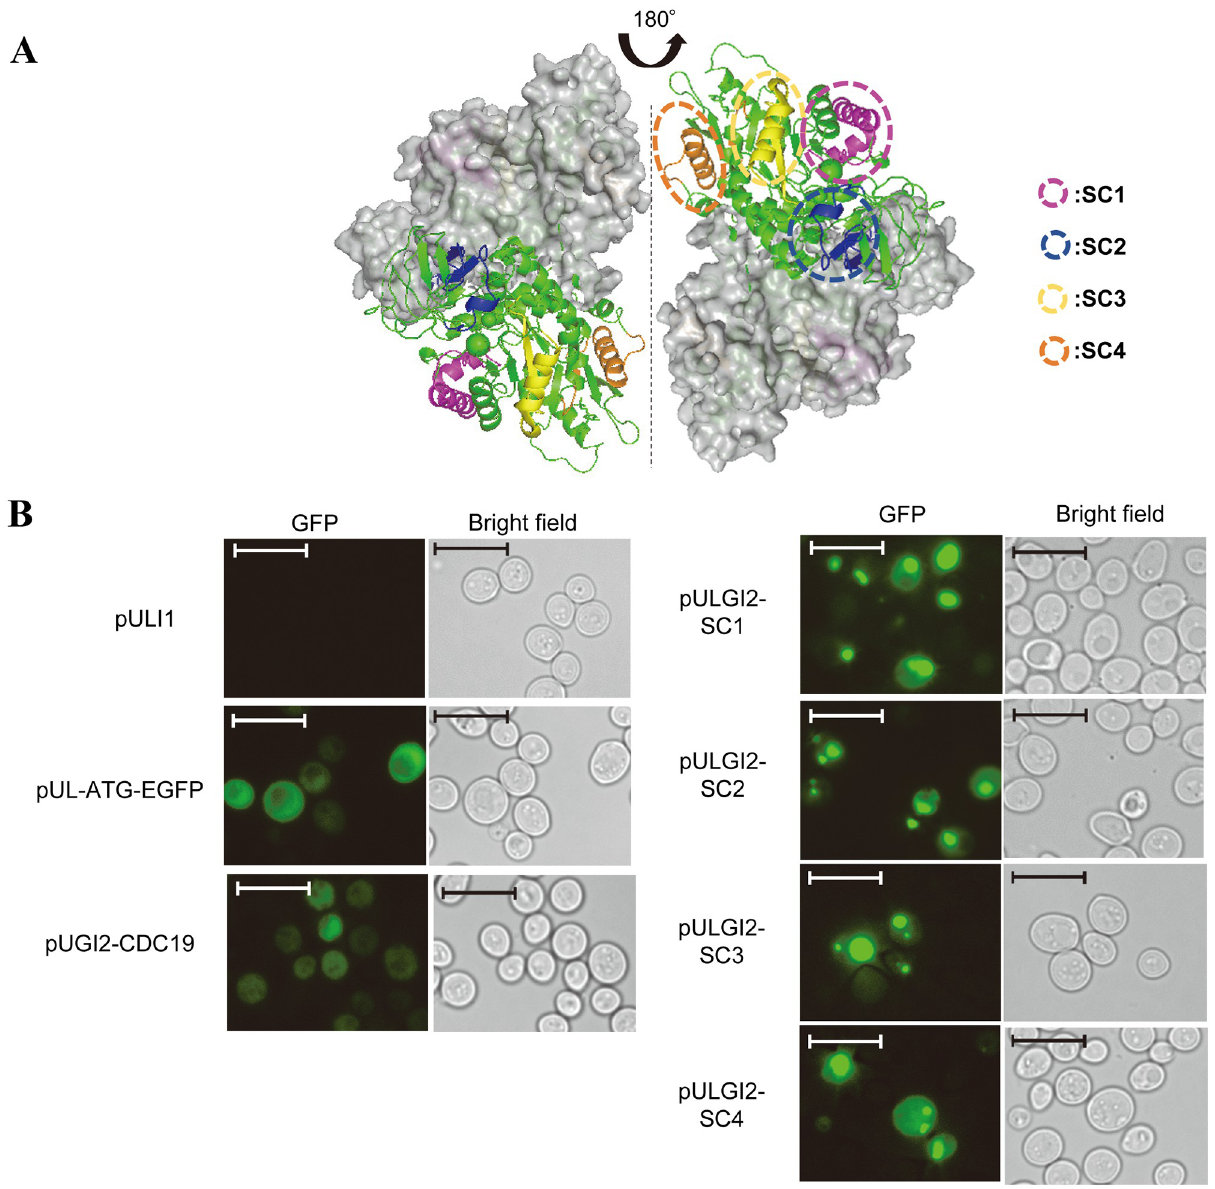
Fig 2. Summary of the four identified foci-forming peptides; SC1, SC2, SC3 and SC4. A: Three-dimensional distribution of identified peptides in pyruvate kinase (CDC19, PDB ID:1A3W) [24]. PyMOL ver. 2.5.2 was used to provide a graphical illustration of identified peptides. SC1, pink; SC2, blue; SC3, yellow; SC4, orange; other domains, green. Two dimers are shown. Gray molecule represents the monomer subunit. B: Images of each EGFP- conjugated fragment in cells under normoxia. pUL-ATG-EGFP indicates images of the S . cerevisiae BY4741 wild type strain cells transformed with the plasmid expressing EGFP only (negative control). pULGI2-CDC19 indicates images of cells transformed with the plasmid expressing full-length Cdc19p fused with EGFP. pULGI2-SCX (X = 1–4) indicates images of cells transformed with the pULGI2-SCX plasmid. Bar = 10 μ m. foci under hypoxia was examined using internal Cdc19p fused with GFP (Cdc19p-GFP) as a marker (Fig 3B). SC2, SC3, or scENO fused with Adh1p-FusionRed colocalized with Cdc19p- GFP, while FUSN and Sup35p fused with Adh1p-FusionRed did not, indicating that META body-derived peptide tags induce translocation of proteins to the META body in vivo . The SC2 and SC3 fragments were further investigated to determine if they colocalized with another